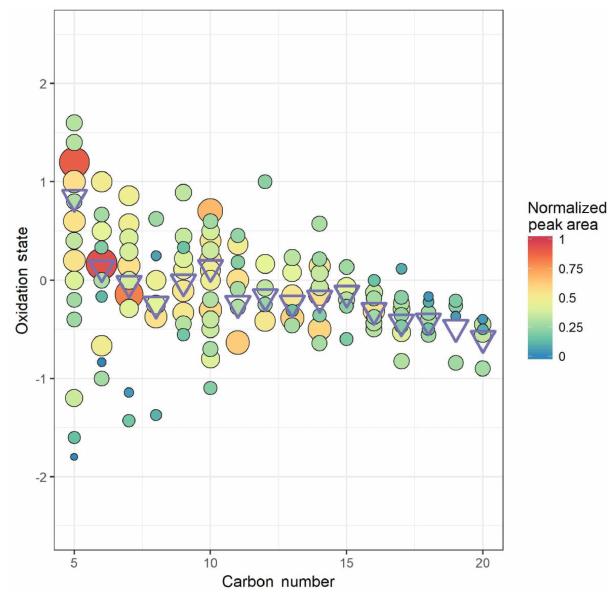
Figure 1. Oxidation state of carbon calculated as 2 times the oxygen-to-carbon ratio minus the hydrogen-to-carbon ratio against carbon number for (coloured) individual ions and (blue circles) signal-weighted average for each carbon number. Area and colour are both proportional to the peak area for each